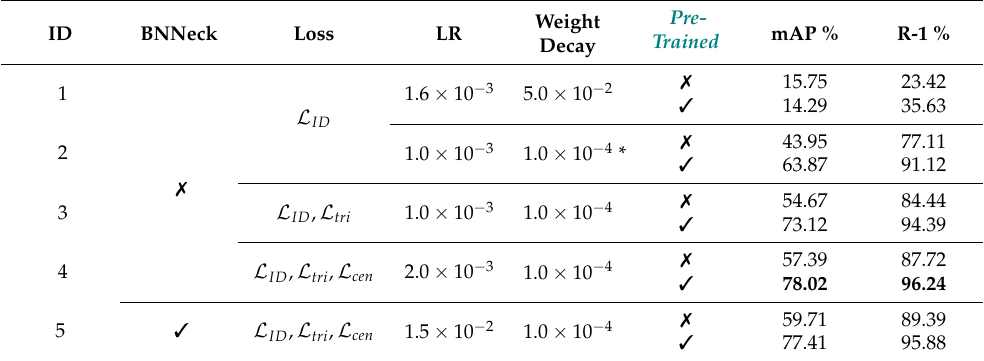
Table 7. Performance of the models: from-scratch vs. pre-trained . The weight decay in * was taken from TransReID [47] and kept for the rest of the experiments.